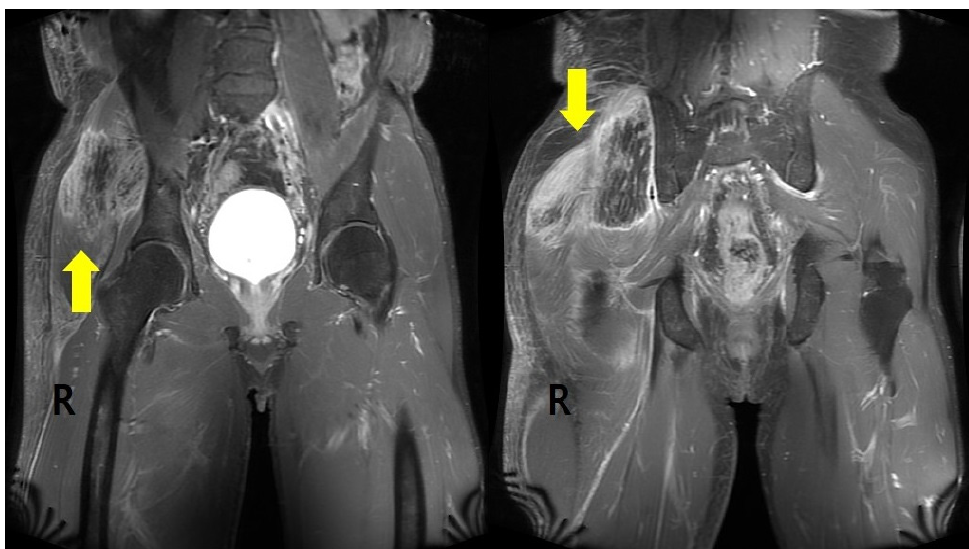
Figure 1. Pelvic MRI axial view shows extensive muscle edema with necrosis involving the right gluteal muscles (arrow) compared with the left side. gluteal muscles (arrow) compared with the left